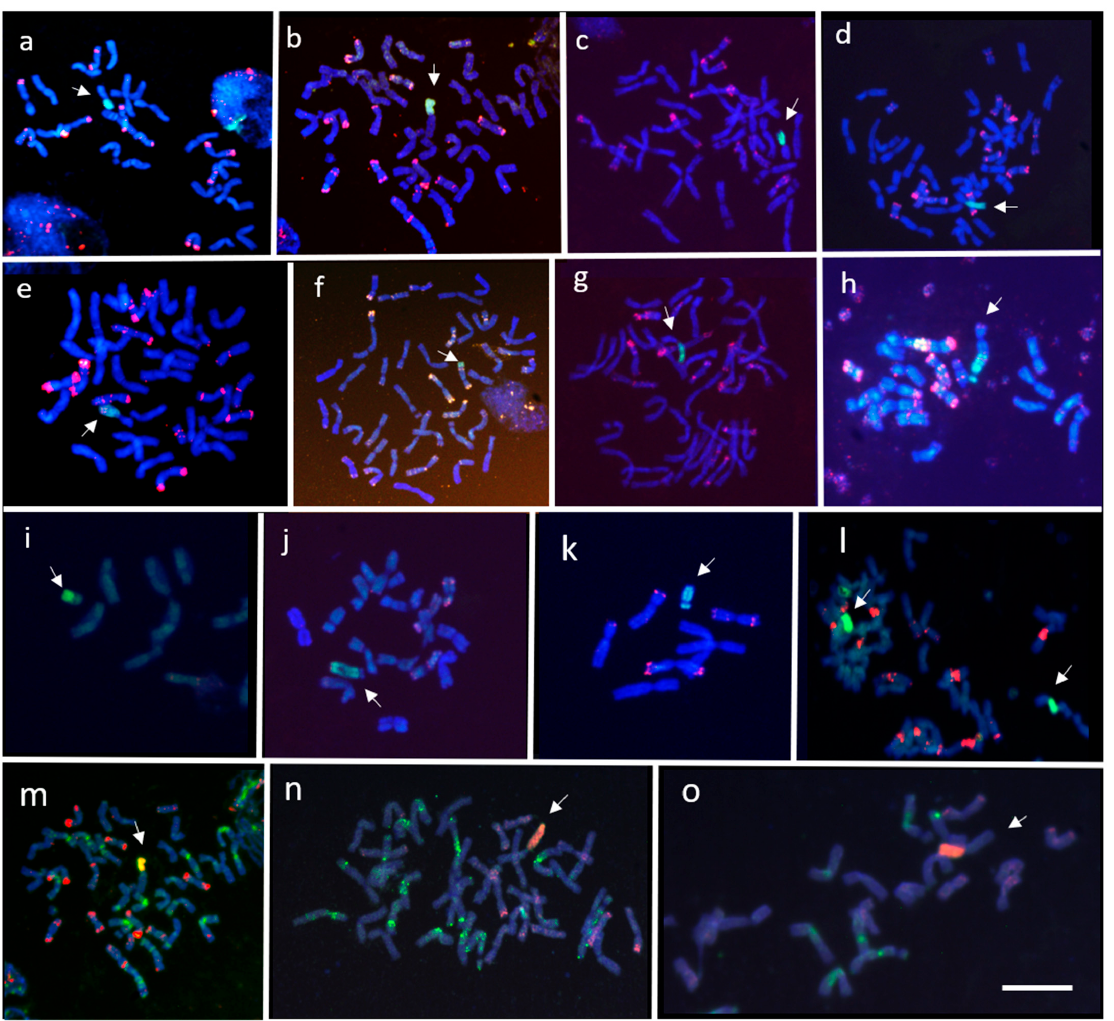
Figure 3. FISH with A. cristatum genomic DNA (green) and pAs1 repetitive (red) probes to mitotic metaphase of wheat- A.cristatum introgression lines. ( a ) wheat-4PS centromeric translocation; ( b ) wheat-4PL centromeric translocation; ( c ) wheat-5PS centromeric translocation; ( d ) wheat-5PL centromeric translocation; ( e ) wheat-6PS centromeric translocation; ( f ) terminal wheat-6PS translocation; ( g ) wheat-6PL centromeric translocation; ( h ) dicentric wheat- A.cristatum involving chromosome 5P ( i ) and ( j ) small wheat- A.cristatum translocations; ( k ) deficient 4P chromosome ( l ) wheat-5PS centromeric translocations hybridized with genomic A.cristatum genomic DNA (green) and GAA repetitive sequence (red); ( m ) the same cell as in ( b ) reprobed with GAA repetitive sequence (green); ( n ) and ( o ) centromeric wheat-6PL and wheat-6PS centromeric translocation, respectively, hybridized with A. cristatum genomic DNA (red) and GAA repetitive sequence (green). Chromosome rearrangements were arrowed. The wheat genetic background is ‘Chinese Spring’. Wheat chromosomes are counterstained with DAPI. (a , c , f , g , l , n , o) obtained by Ph1b mutant; (b , d , e , h , i , j , k , m) obtained by gametocidal 2C c chromosome. Scale bar, 10 μ m.